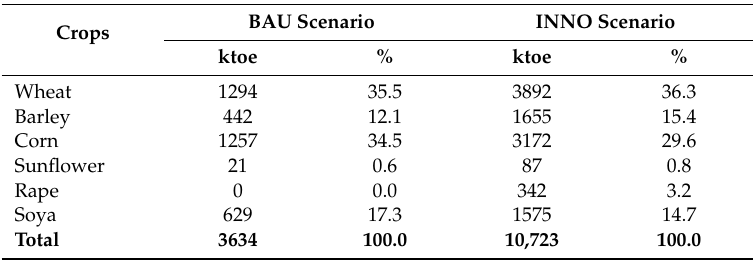
Table 7. Economic potential of bioenergy generation from the main crop residues in Ukraine in